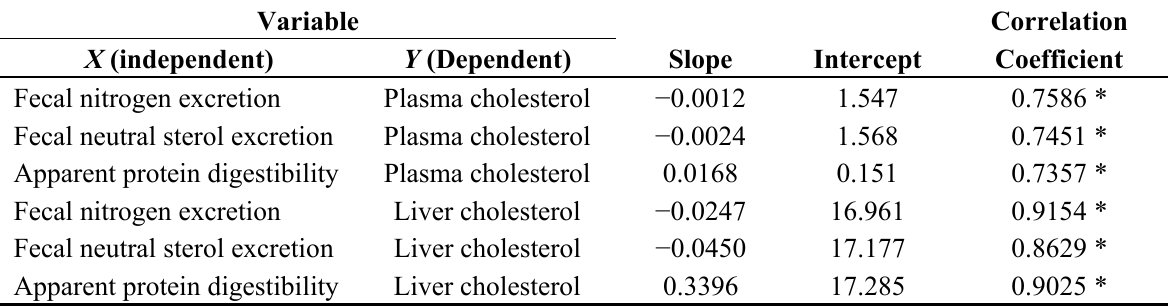
Table 7. Correlation analyses of factors to affect plasma and liver cholesterol concentrations in rats fed dietary